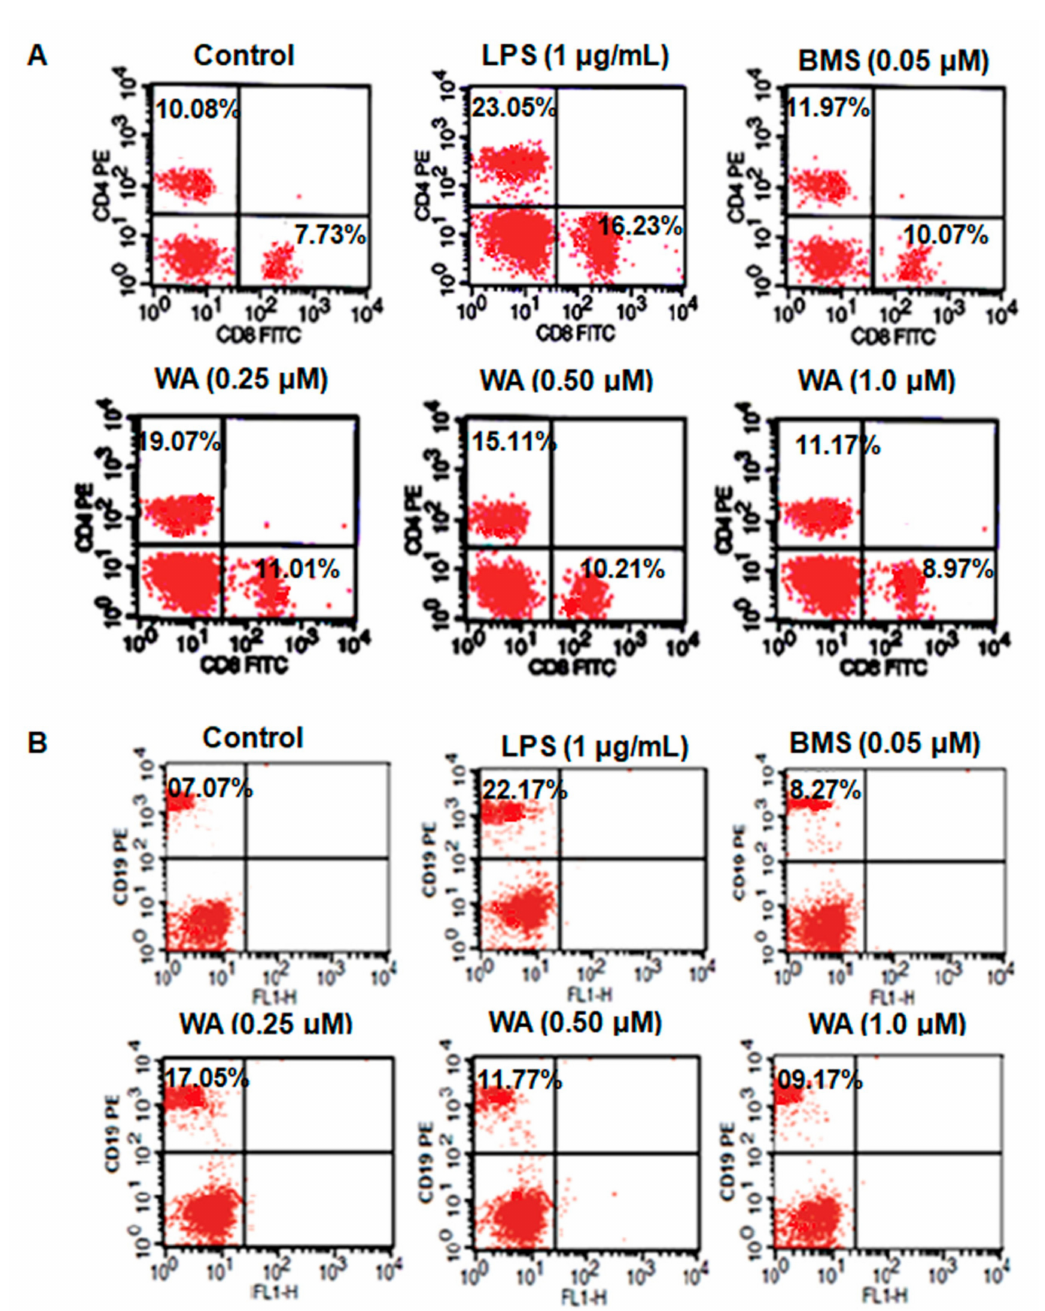
Figure 7. WA immunomodulates the LPS-stimulated splenocytes derived from BALB/c mice. ( A ) Quantification of T cell subsets (CD4/CD8) by flow cytometry of LPS/ConA-stimulated spleno- cytes exposed to indicated doses of WA and labeled with surface antibody markers CD4 (PE-coupled monoclonal antibody) and CD8 (FITC-coupled monoclonal antibody). ( B ) Quantification of B cells (CD19) by flow cytometry of LPS-stimulated splenocytes exposed to indicated doses of WA and labeled with surface antibody markers CD19 (PE-coupled monoclonal